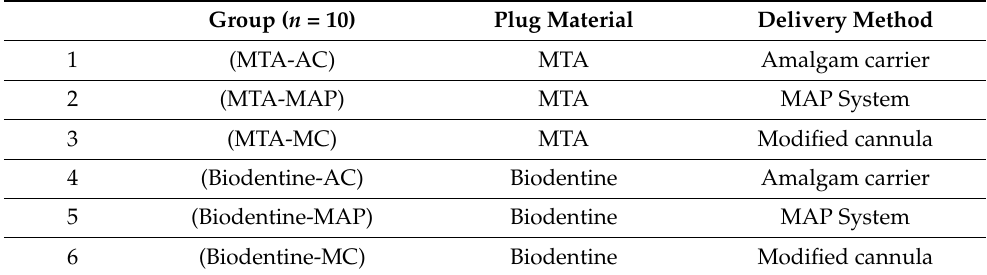
Table 1. Experimental